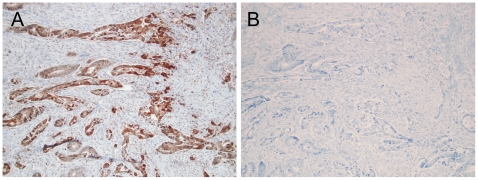
CB1 receptor immunoreactivity in tumour samples.Sections from the same case were used in the presence (Panel A) and absence (Panel B) of the primary antibody. Objective magnification is 10×.